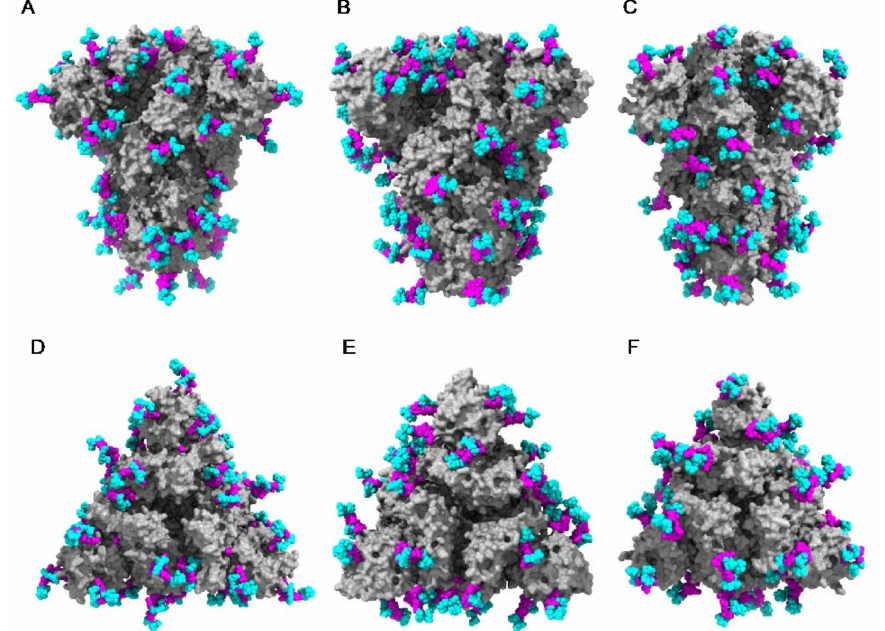
Figure 35. ( A – C ). Lateral views of the molecular surfaces (colored grey) of spikes from SARS-CoV (PDB code 6ACD) ( A ), MERS-CoV (PDB code 5W9H) ( B ), and SARS-CoV-2 (PDB code 6VXX) ( C ), showing the exposure of the fucosylated and non-fucosylated tri-mannosyl cores (colored magenta) of high mannose glycans and complex glycans (colored cyan). ( D – F ). Front views of the molecular surfaces (colored grey) from SARS-CoV ( D ), MERS-CoV ( E ), and SARS-CoV-2 ( F ), showing the exposure of the fucosylated or non-fucosylated tri-mannosyl cores (colored magenta) of high mannose glycans and complex glycans (colored